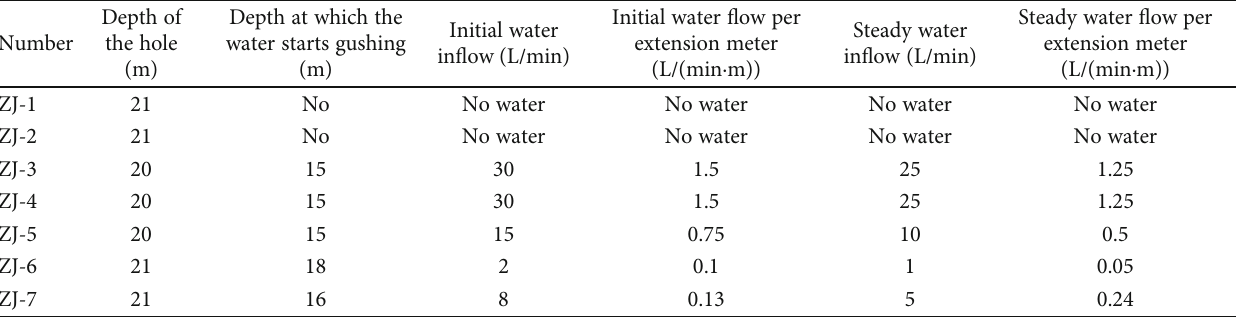
Figure 12: Layout of detection hole: (a) cross section and (b) longitudinal pro fi le. ZJ1 ~ ZJ6 in the fi gure is the opening position of the inspection hole, and ZJ1 ′ ~ ZJ6 ′ is the fi nal hole position. Table 2: Test results of water in fl ow through the